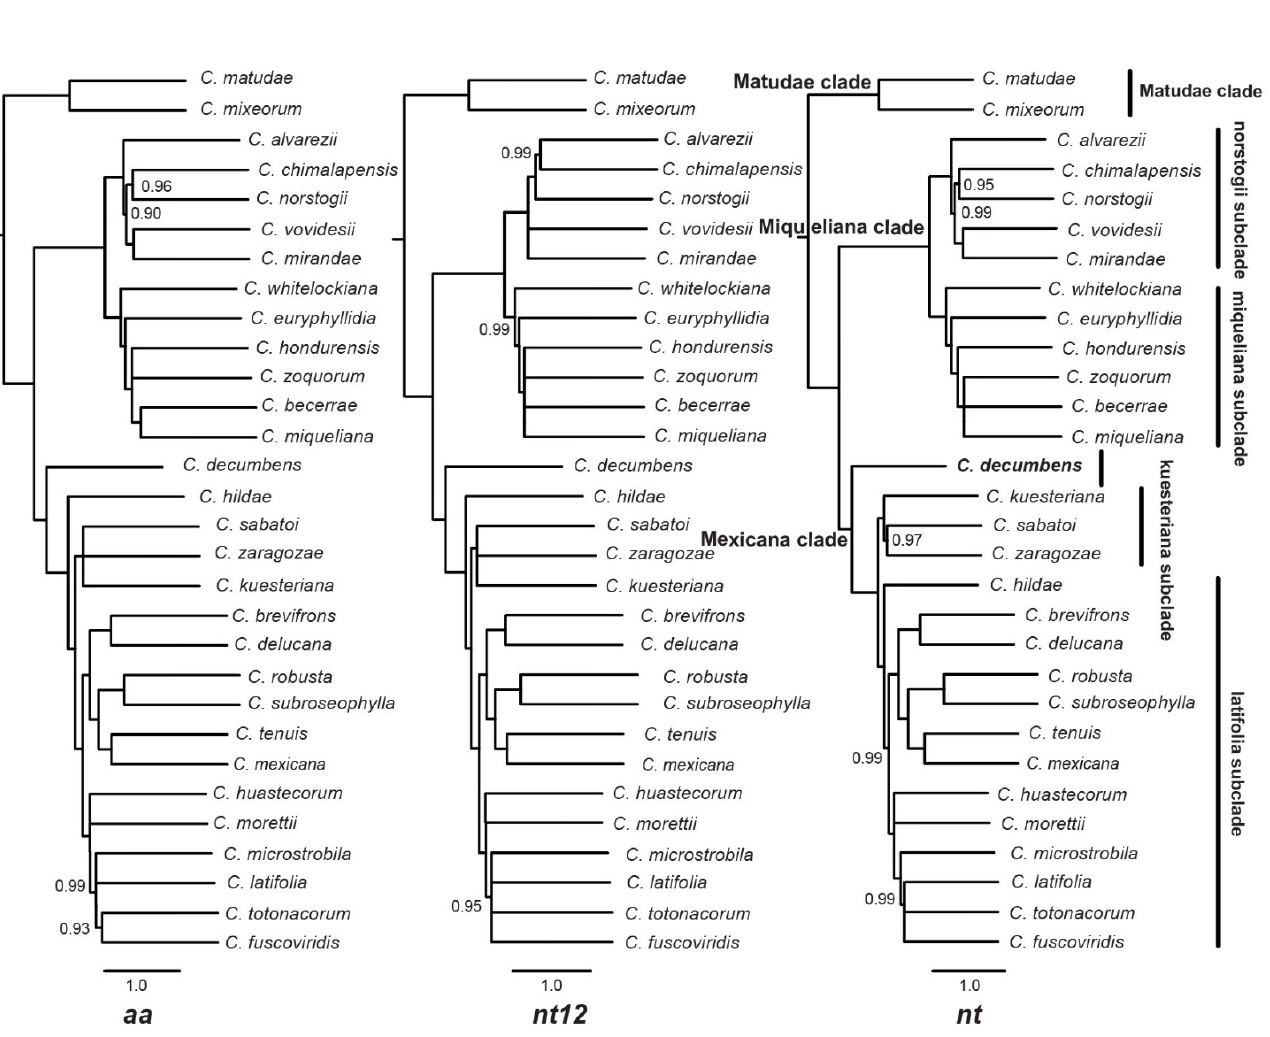
Figure 3. Maximum likelihood topology of the Ceratozamia species relationships inferred from the coalescence analyses of 3954 SCGs and the three comparative datasets (aa/nt12/nt). Posterior probability < 1.0 is given on the nodes. Branches with PP < 0.85 are collapsed. The six groups within the genus proposed in the current study are labeled.